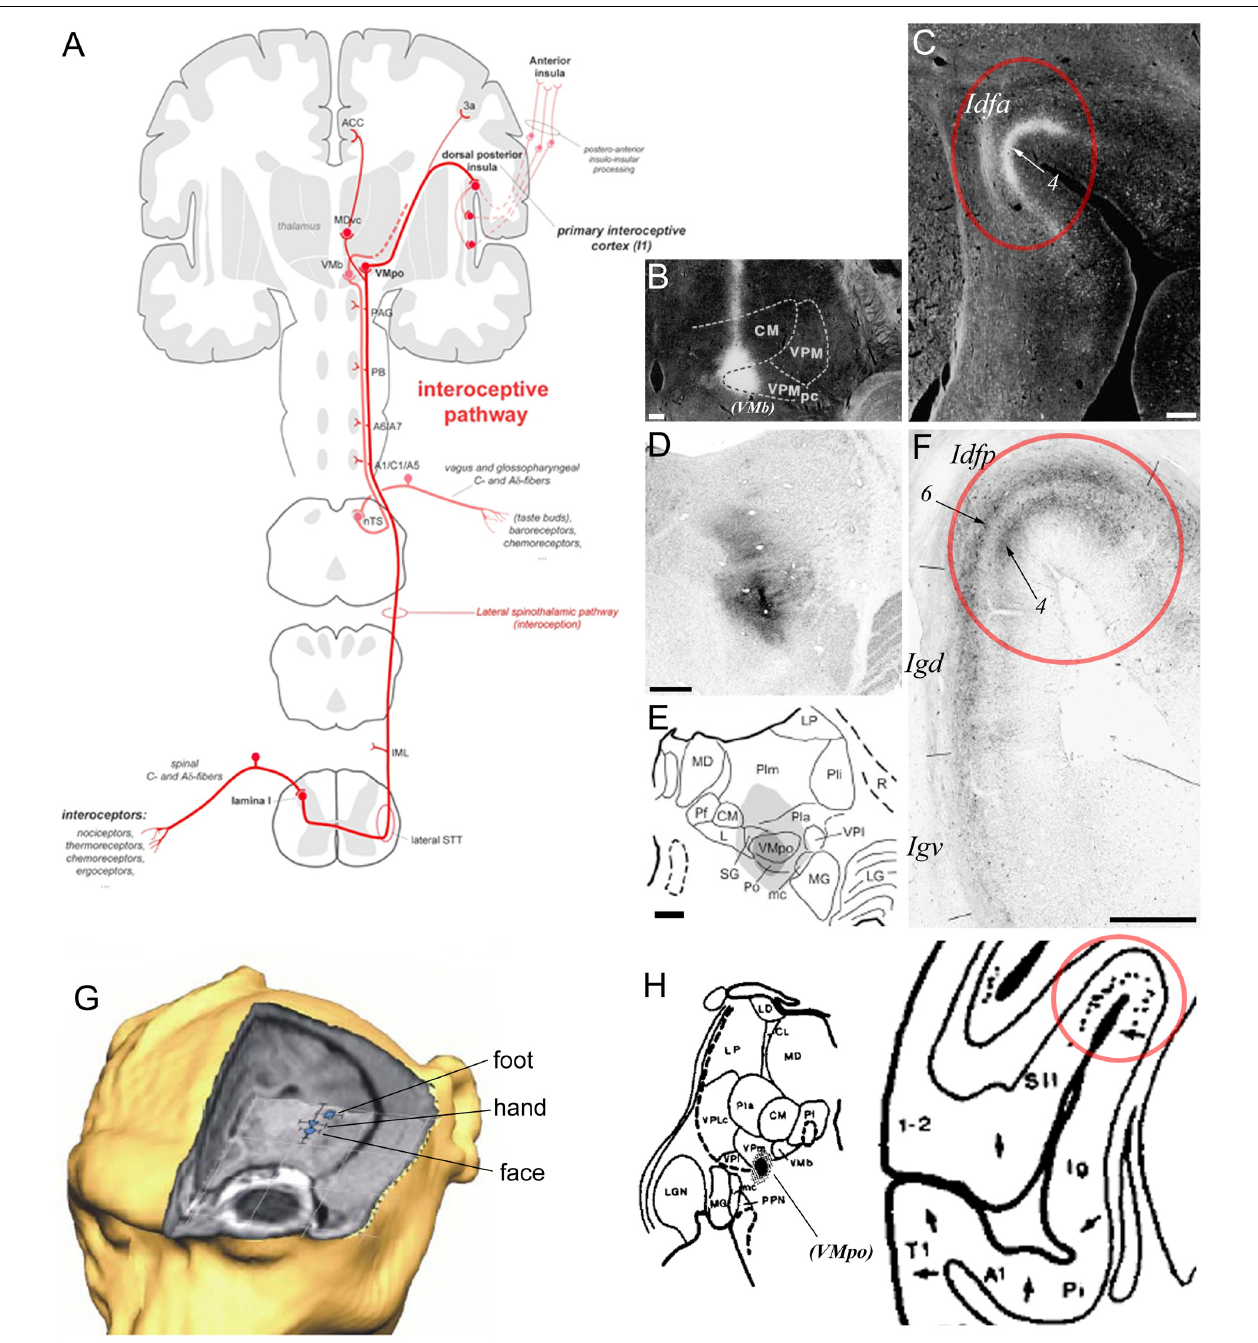
FIGURE 4 | Primate ascending interoceptive pathway and primary interoceptive cortex. (A) Schematic representation of the ascending interoceptive pathway in primates. Inspired from Craig (2003b). (B , C) Darkfield photomicrographs of coronal sections in a rhesus macaque monkey brain, showing an autoradiographic injection site of tritiated amino acids in VMb (labeled here “VPMpc”), and its resulting anterograde labeling in Idfa (Pritchard et al., 1986). The labels “(VMb)”, “Idfa” and “4” were added by the present author. (D – F) Brightfield photomicrographs and chart of coronal sections in a cynomolgus macaque monkey brain showing an immunoreacted injection site of cholera toxin b centered in VMpo (D , E) and its resulting anterograde labeling in layer 4 in Idfp (Craig, 2014). Retrograde labeling also occurred in Idfp layer 6 and the adjacent area Igd. (G) 3D representation of the estimated localization of the insular thermal laser-evoked potential (LEP) sources for the stimulation of the head, hand, and foot in one cynomolgus macaque monkey (Baumgartner et al., 2006). (H) Plot of an injection site of tritiated amino acids in a small thalamic region corresponding to VMpo, in between VPI and VMb, in case RM17R (left), and distribution of the anterograde labeling produced by this injection in the dorsal fundus of the insular cortex, a region corresponding to Idfp (right) (Burton and Jones, 1976). The label “(VMpo)” was added by the present author. All illustrations in the panels of this figure were adapted with permission from the publishers of the cited references.